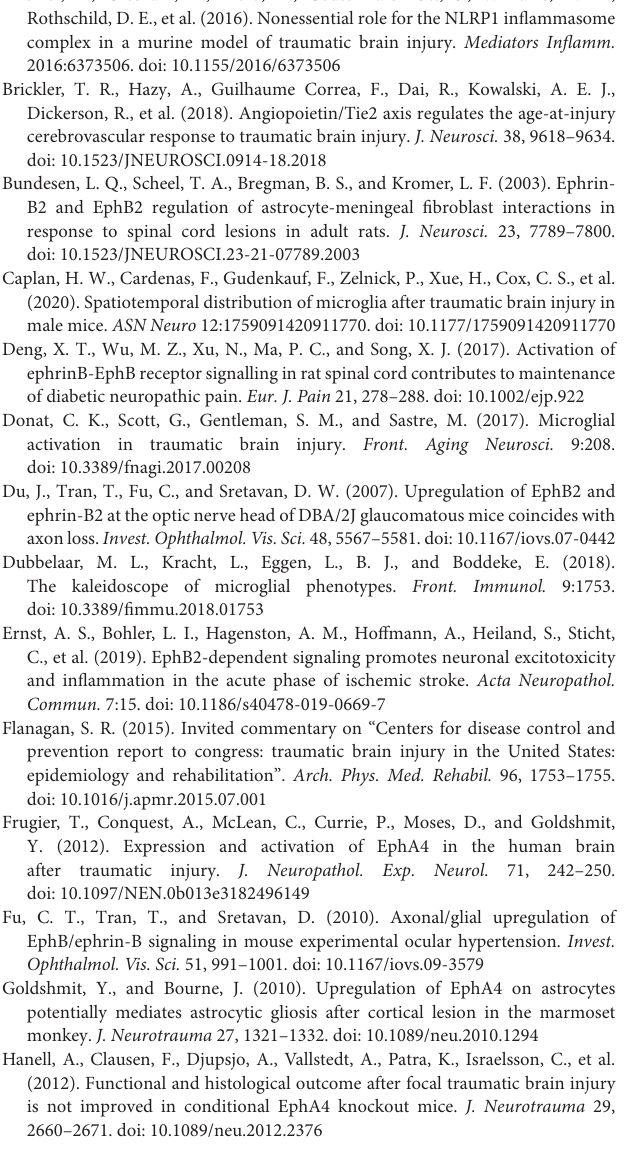
bp). Heterozygous Cx3cr1 CreER / + shows both Cx3cr1-WT (695 bp) and Cx3cr1-mutant (300 bp) alleles. Mutant Cx3cr1 CreER / CreER shows Cx3cr1-mutant (300 bp) allele only. (C,D) Body weight and cortex (Ctx) mantle thickness of EphA4 f / f , Cx3cr1 CreER / creER EphA4 + / + , Cx3cr1 CreER / + EphA4 + / + , and Cx3cr1 CreER / + EphA4 f / f mice. ns, nonsignificant difference was observed between different groups. (E–H) Representative images for the contralateral cortex of Nissl-stained coronal sections taken at 4 × magnification. N = 5–13, ns, nonsignificant difference was observed between different groups. Supplementary Figure 4 | Blood-brain barrier (BBB) permeability was measured at 3 dpi using tail vein injection of Evan’s blue dye. The absorbance of Evan’s blue in the ipsilateral hemispheres was measured at 610nm and compared to the contralateral of each group. N = 5–6, ∗ p < 0.05, compared to the corresponding